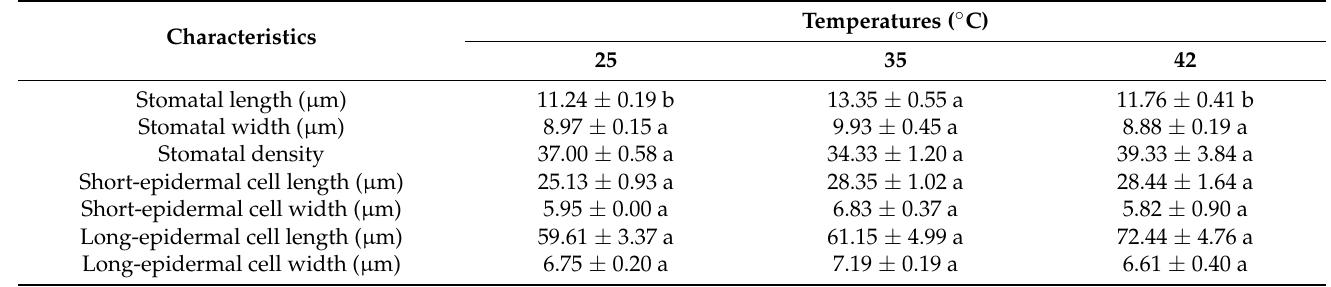
Figure 5. Surface anatomy of KDML105 leaves at different levels of heat stress. ( A ) The control or 25 ◦ C; ( B ) 35 ◦ C; ( C ) 42 ◦ C. Table 3. Anatomical responses of KDML105 seedlings after treatment at 25 (control), 35 and 40 ◦